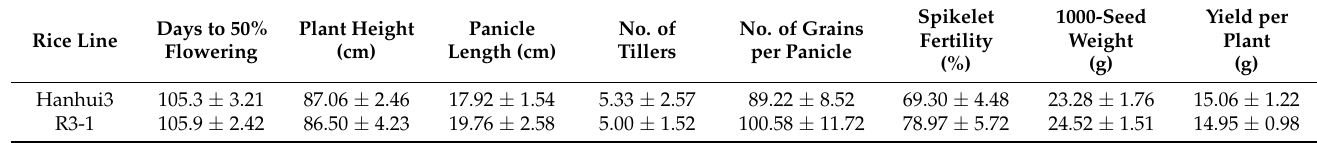
Table 4. The yields and agronomic performances of Hanhui3 and NIL under drought